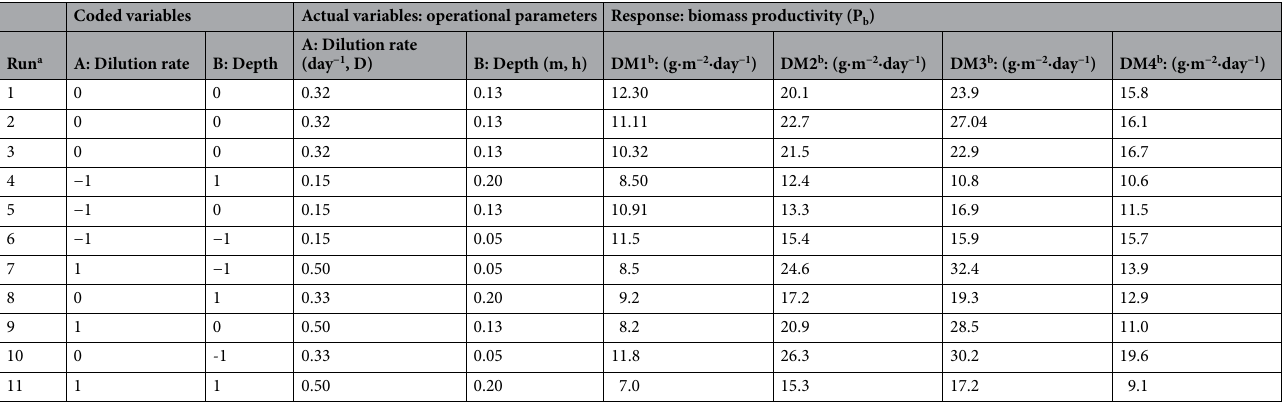
Table 1. Central composite response surface designs for biomass productivity in winter (DM1), spring (DM2), summer (DM3) and autumn (DM4). a Run number does not correspond to the number of processing, which was conducted randomly. b Values represent the mean of two independent experiments. DM1, DM2, DM3, and DM4 were the set of experiments conducted in winter, spring, summer, and autumn,